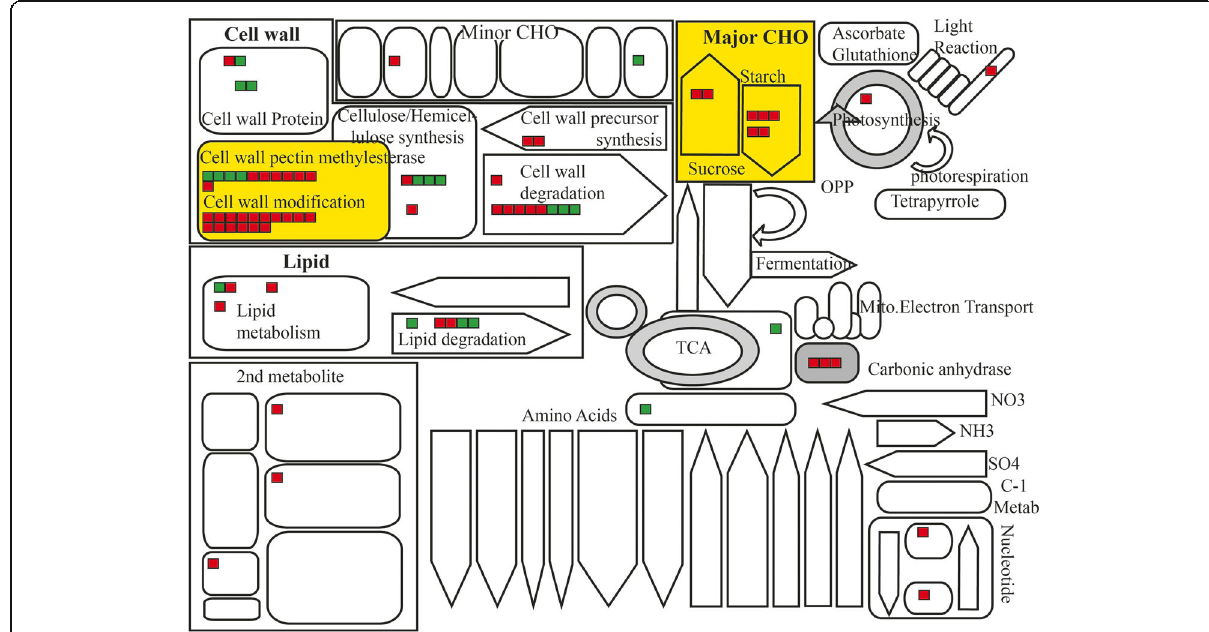
Fig. 5 Enriched metabolic pathways in rice late pollen-preferred genes compared to those of Arabidopsis . Red squares, genes unique to rice; green squares, conserved genes in terms of their sequence homology and expression patterns between 2 plant